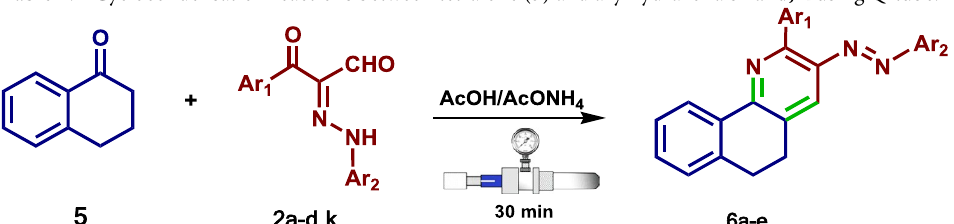
Table 4. Cyclocondensation reactions between tetralone ( 5 ) and arylhydrazonals 2a–d, k using Q-tube.